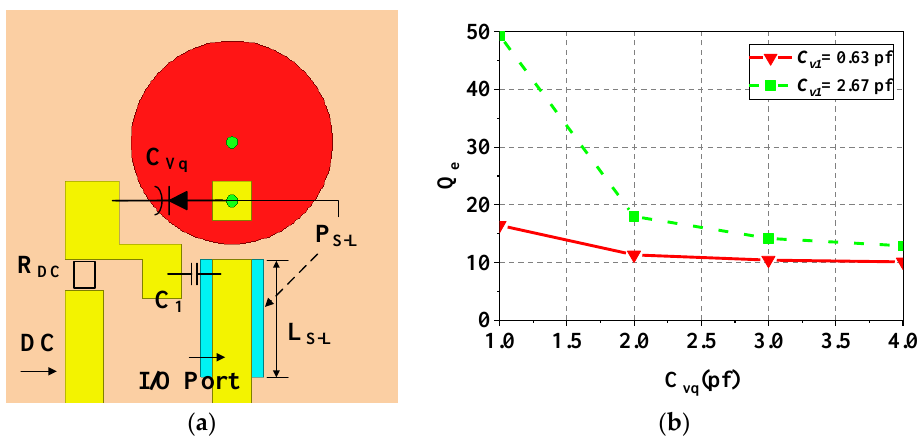
Figure 9. ( a ) Top view of the structure of the I/O port. ( b ) Simulated Q e versus C vq for different C v1 .